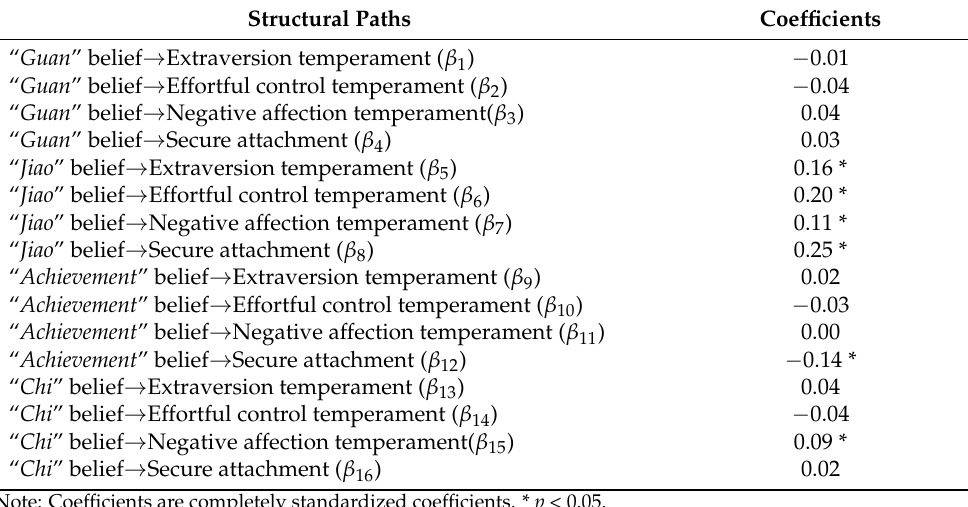
Table 1. The structural coefficients of Chinese parenting beliefs on preschooler’s temperament and secure attachment.